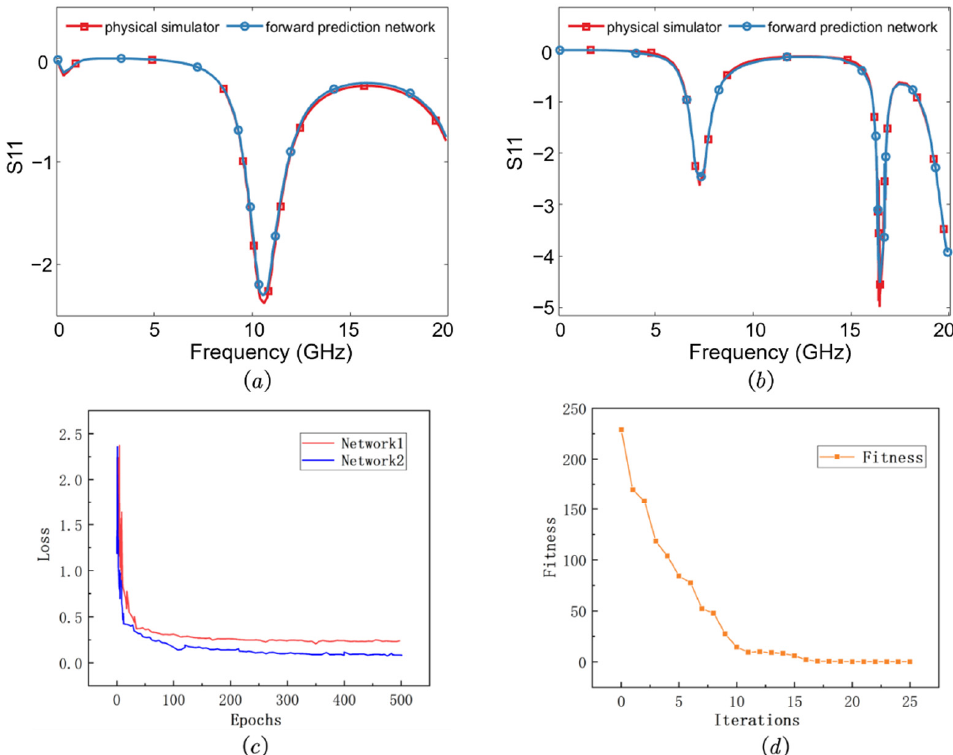
Figure 10. ( a , b ) The response curve calculated by the physical simulator and the prediction curve of the forward prediction network. ( c ) Validation loss of network 1 and network 2. ( d ) The process of VAE-PSO.